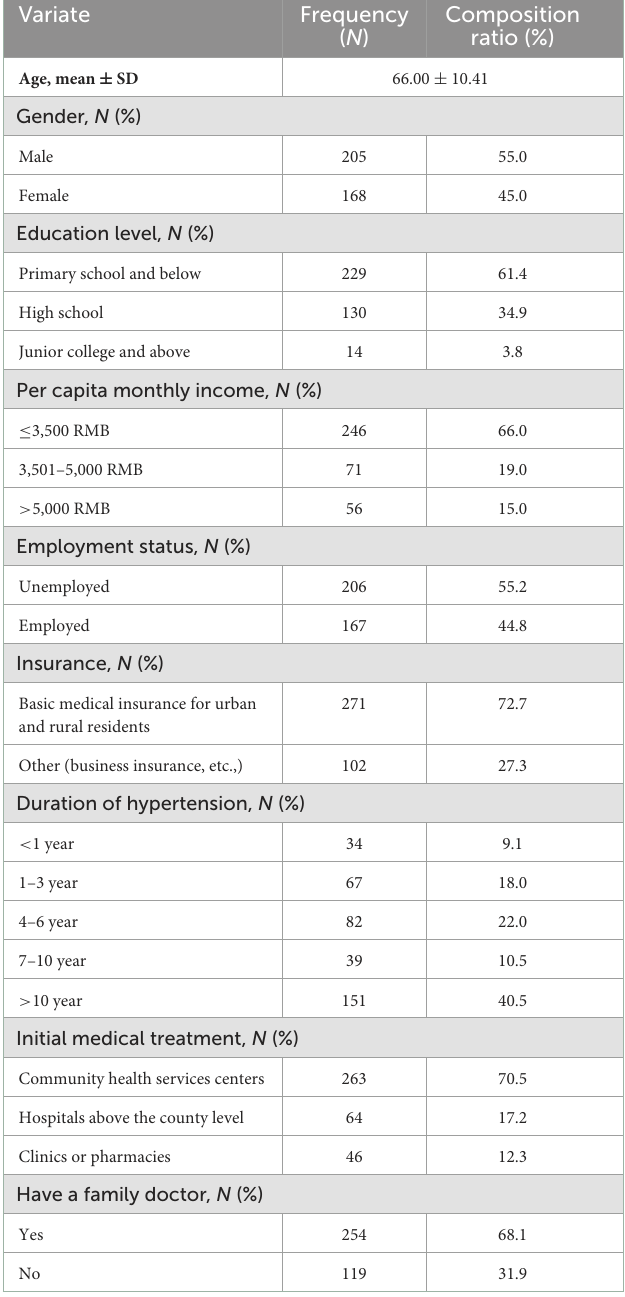
FIGURE1 Structural framework of hypothesized relationships.